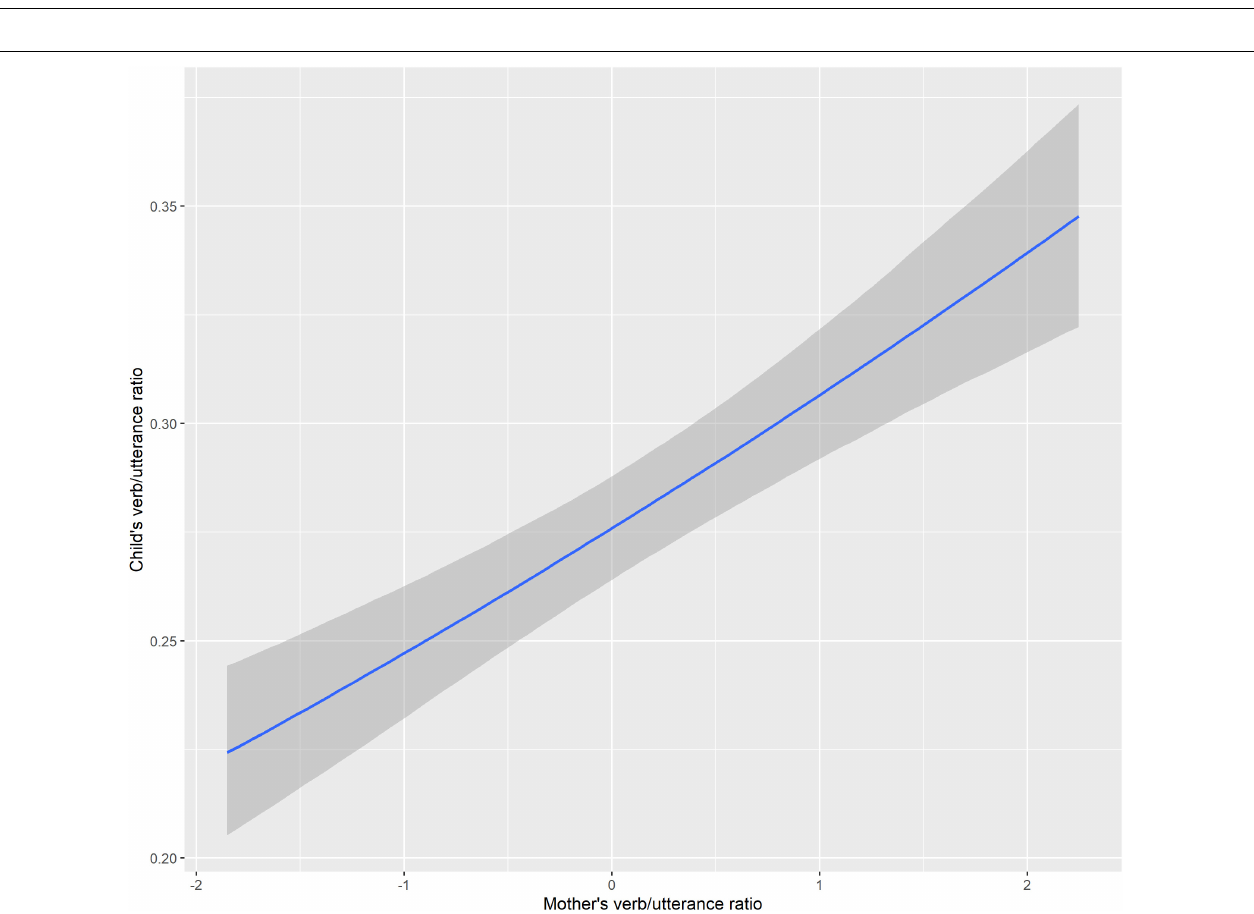
Frontiers in Psychology |